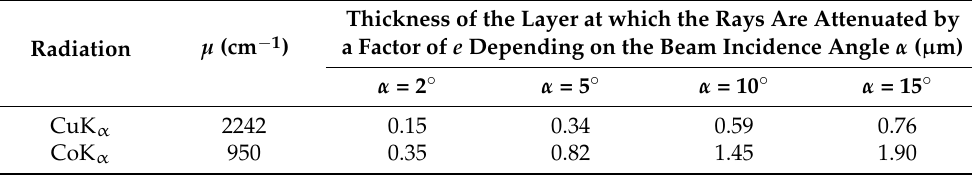
Table 1. Penetration depth of